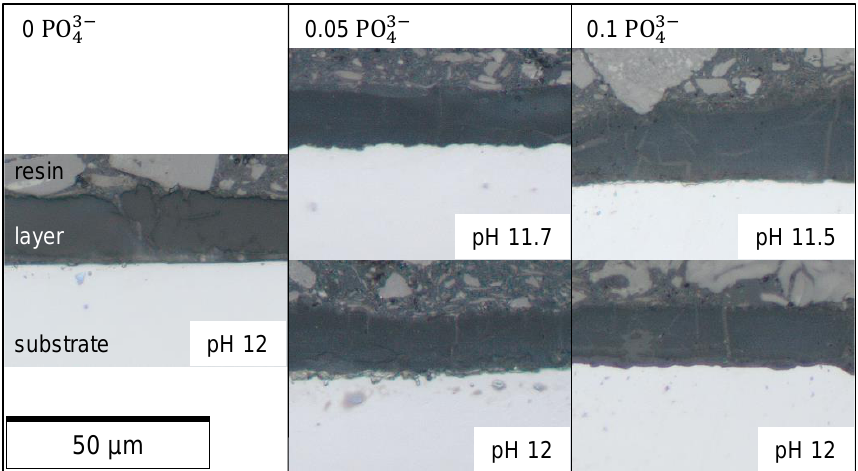
Figure 8. Optical microscopic images of the cross-sections after polarization at constant potential (OCP + 4 V) in the different electrolytes, categorized by the phosphate content in the electrolyte ( PO 43− ) in mol/L and the pH. The scale bar applies to all images.